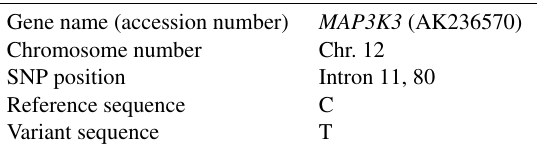
Table 5. Identification of SNPs in MAP3K3. Table 6. Allele frequency of the SNP in